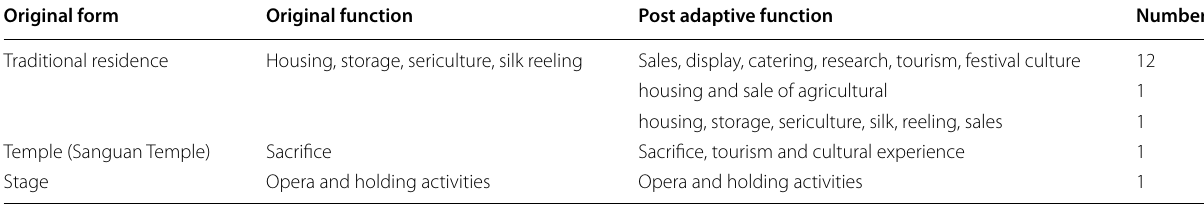
Table 2 Traditional architectural adaptation changes to Digang Food